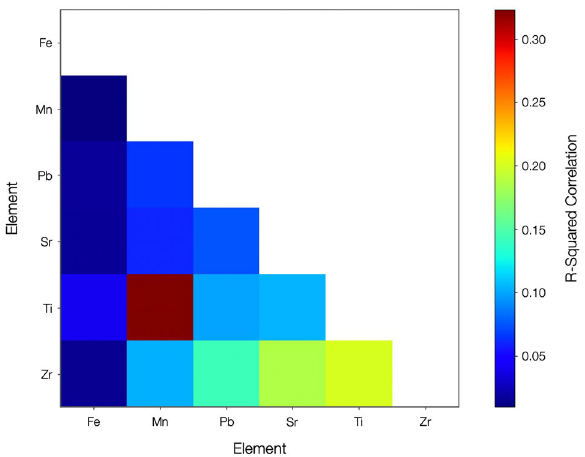
Figure 8. Species coincidence analysis of pixel elemental signatures determined using SR-µ-XRF mapping of the Unit 1 derived, CF-01-R024,